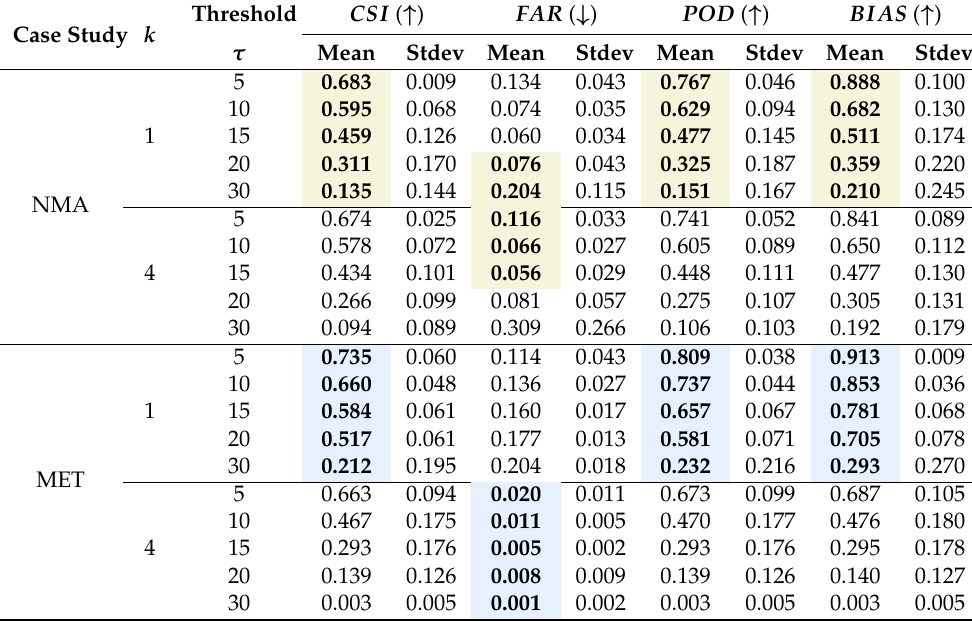
Table 3. The results for the classification evaluation metrics for predicting one time step in the future. The means and standard deviations that were computed across the three experimental runs are shown. The best values for the performance metrics are marked with bold and colored with yellow (for the NMA case study) and with blue (for the MET case